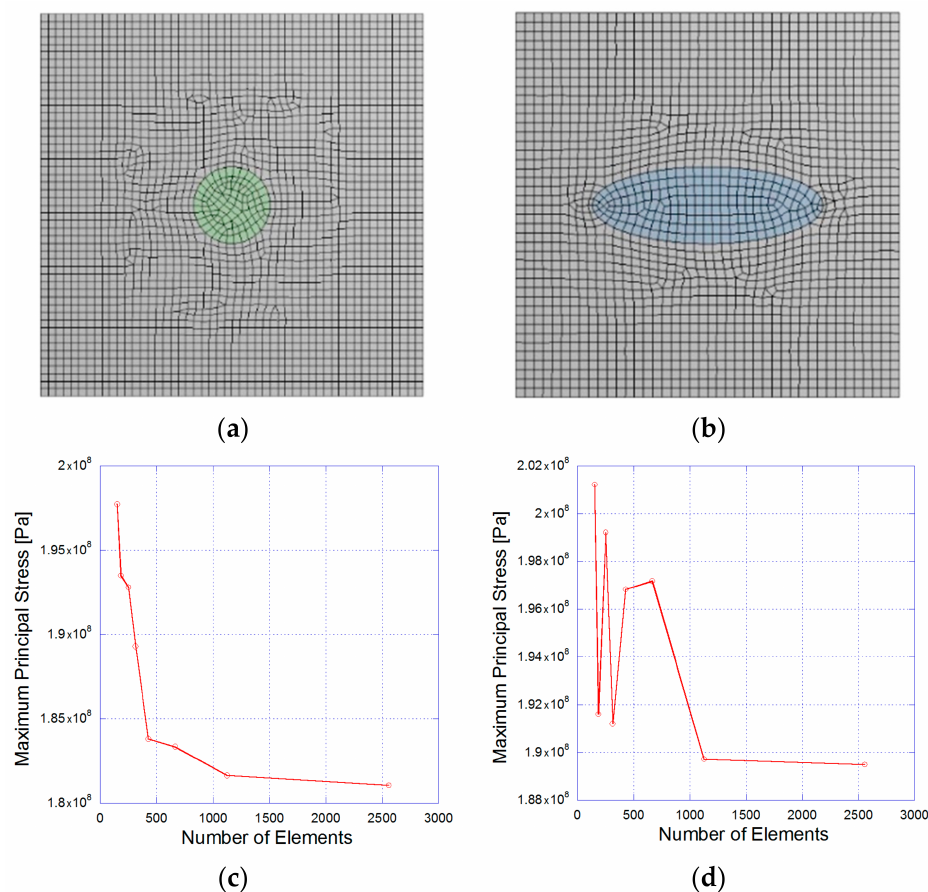
Figure 2. A resulting mesh of the aluminum matrix with ( a ) the circular microparticle, ( b ) the oval microparticle, the maximum principal stress for the number of elements for ( c ) the circular microparticle, and ( d ) the oval